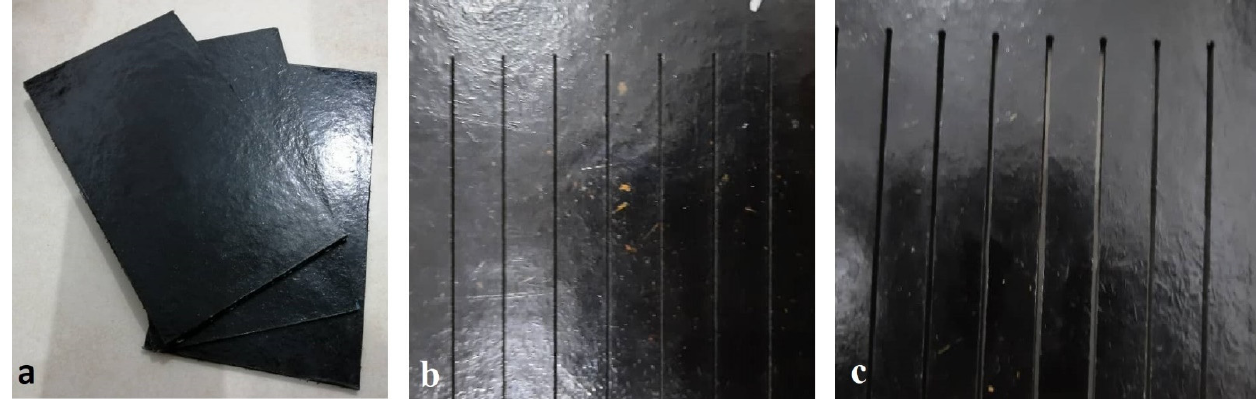
Figure 1. ( a ) The composite specimens before cutting processes. ( b ) Specimen cut with Laser beam cutting technology. ( c ) Specimen cut with abrasive waterjet cutting technology.